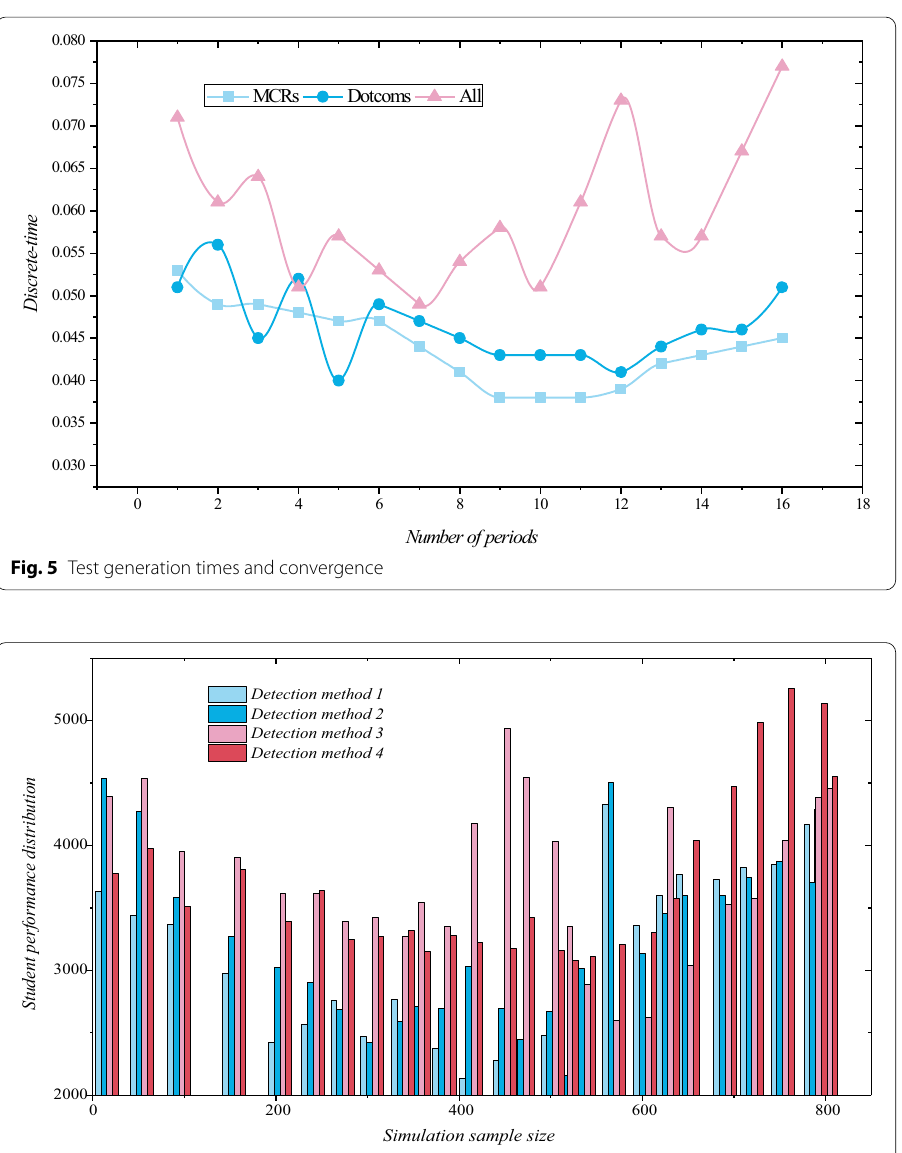
Fig. 6 Distribution of the number of students in English